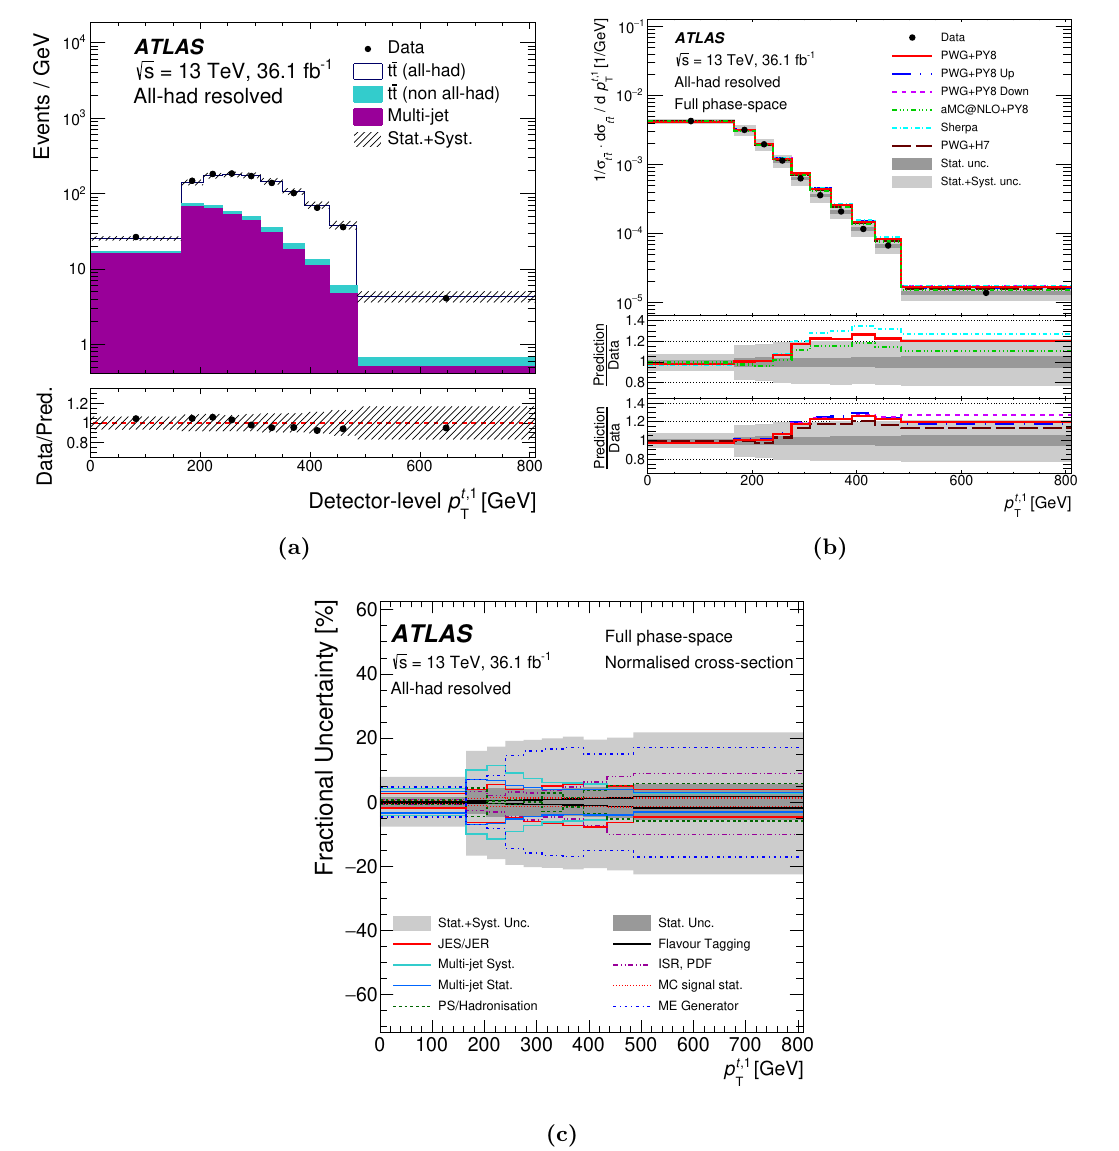
Figure 18 . Comparison of the ATLAS data with the fully simulated nominal SM predictions (a) for the leading top-quark transverse momentum. The shaded bands represent the uncertainties in the total prediction. Data points are placed at the centre of each bin. The lower panel shows the ratios of the data to theoretical predictions. Overflow events are included in the last bin of every distribution shown. Single-differential normalised cross-section measurements, unfolded at parton level (b), as a function of the leading top-quark transverse momentum. The unfolded data are compared with theoretical predictions. In the top panel, the unfolded data are shown as black points, while lines indicate the predictions from several MC programs. Uncertainties are shown by the shaded bands. Data points are placed at the centre of each bin. The lower two panels show the ratio of the MC predictions to the unfolded data. Fractional uncertainties for the normalised single-differential distributions unfolded at parton level (c) as a function of the leading top-quark transverse momentum. The bands represent the uncertainties in the unfolded data. Lines indicate the breakdown of the major components of the